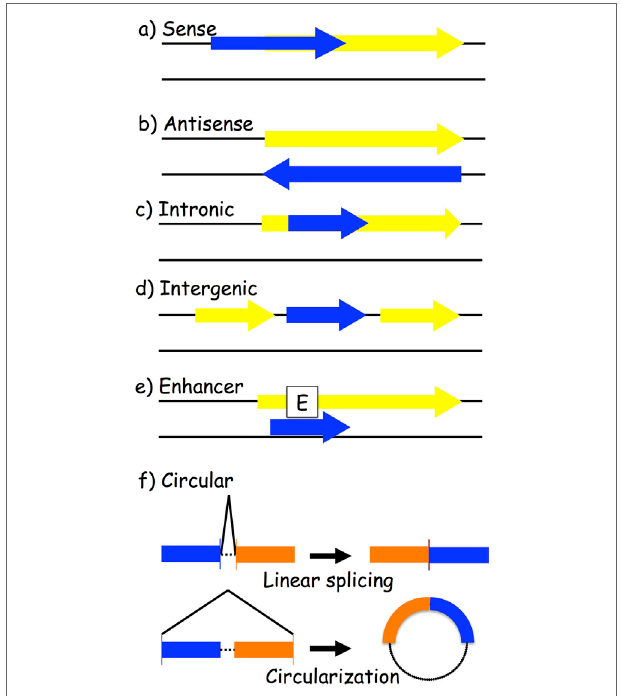
FigURe 2 | biogenesis of long-non-coding RnAs (lncRnAs) . LncRNA transcripts (blue box) are classified based on their genomic location in relation to the closest gene (yellow box): (a) sense lncRNAs are transcribed on the same strand as an exon; (b) antisense lncRNAs are transcribed on the opposite strand of an exon; (c) intronic lncRNAs; (d) intergenic lncRNAs are located between two different genes; (e) enhancer lncRNAs arise from an enhancer region of a protein-coding gene; and (f) circular RNAs are exonic or intronic sequences that circularize following an alternative splicing of linear